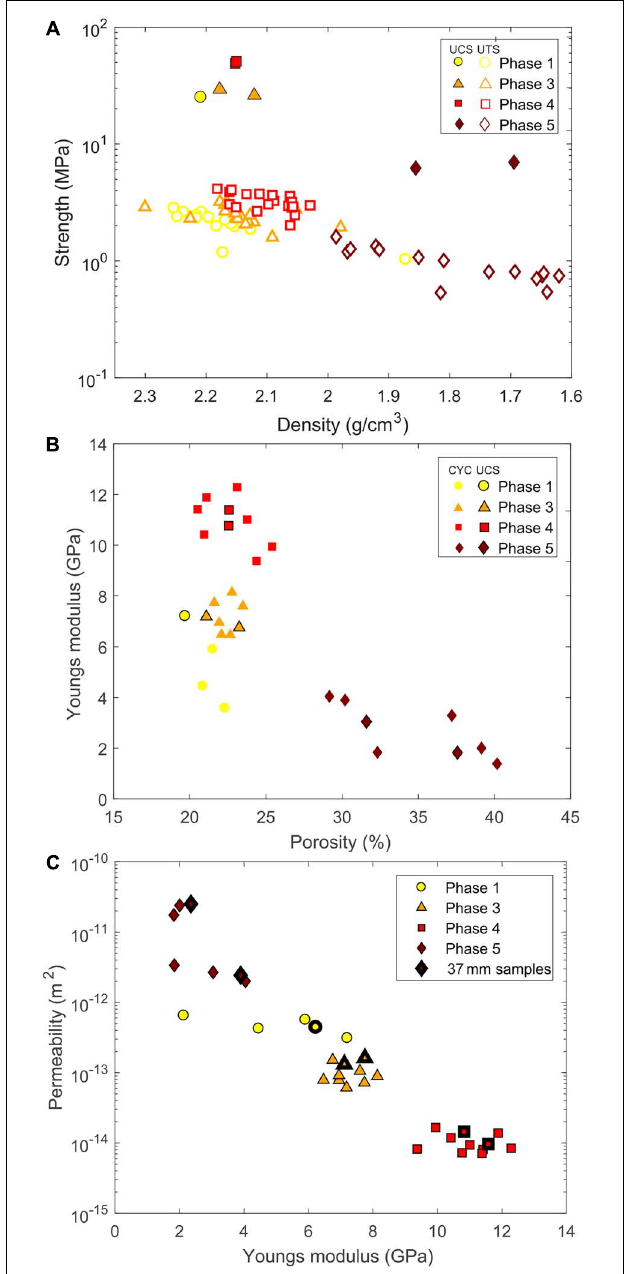
FIGURE 9 | (A) Uniaxial tensile strength (UTS; hollow symbols) and uniaxial compressive strength (UCS; filled symbols) as a function of rock density (a proxy for porosity, see Supplementary Table S1 and Supplementary Figure S1 ). (B) Young’s modulus as a function of connected porosity, determined from UCS tests (black symbol outlines) and from cyclic tests (no symbol outline). (C) Permeability as a function of Young’s modulus, for 26 mm samples (thin symbol outline) and 37 mm samples (thick symbol outline).